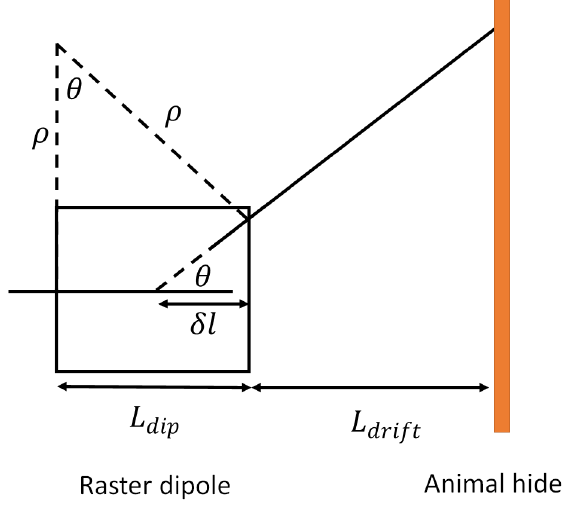
Figure 2. Schematic diagram showing the geometry of the beam trajectory through the raster scanning magnet to the hide. θ is the deflecting angle of the magnet, ρ is the radius of curvature, δ l is the apparent turning point of the beam from the end of the magnet when modelling the magnet as an instantaneous impulse, L dip is the length of the dipole magnet and L drift is the length of the drift section after the dipole